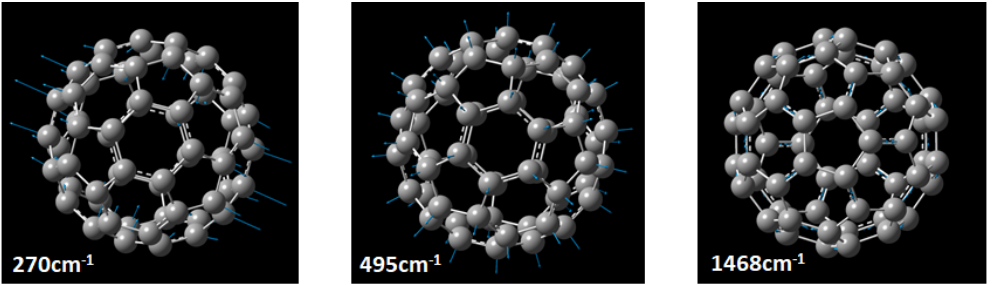
Figure 9. Graphical representation of Wagging, Breathing and Twisting vibrational modes of C 60